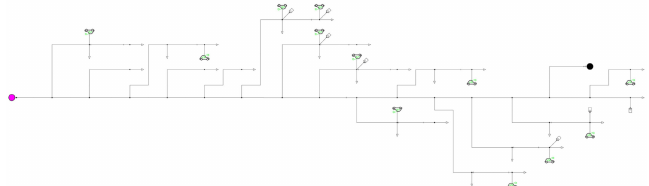
Figure 3. Single line diagram of Feeder 067 in DIgSILENT PowerFactory with 50% penetration of